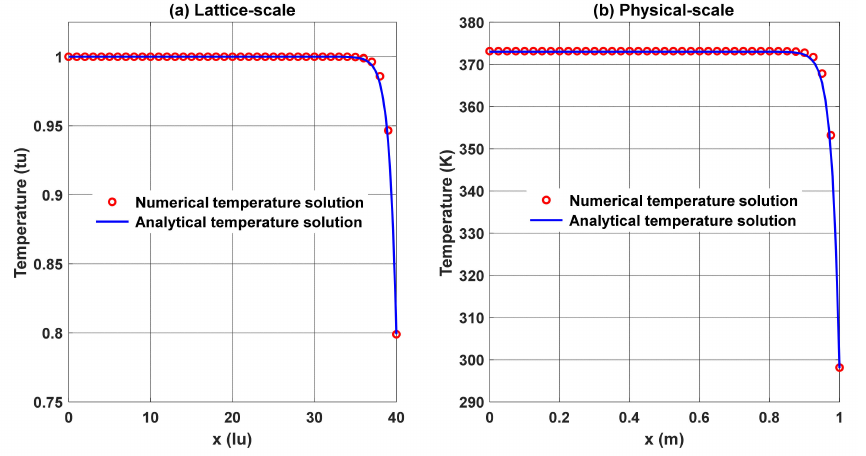
Figure 6. Numerical and analytical solutions of the steady-state temperature distribution along the domain; ( a ) solutions at the lattice-scale (the analytical solution is achieved using Equation (77) at the lattice-scale), and ( b ) solutions at the physical-scale (the numerical solution is achieved by the LBM then converted to the